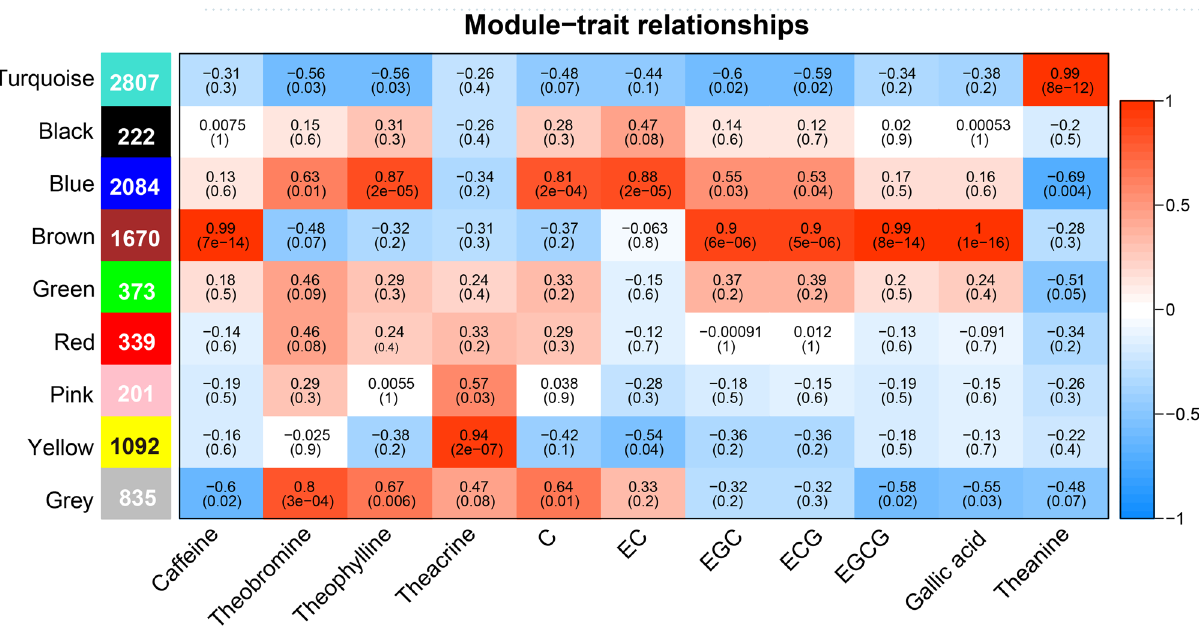
Figure 6. WGCNA analysis of DEGs. The left box indicates the number of genes in each module. The color and number of each cell indicate the correlation coefficient between the module and metabolite content, respectively. Blue and red colors indicate the negative and positive correlation between modules and compound